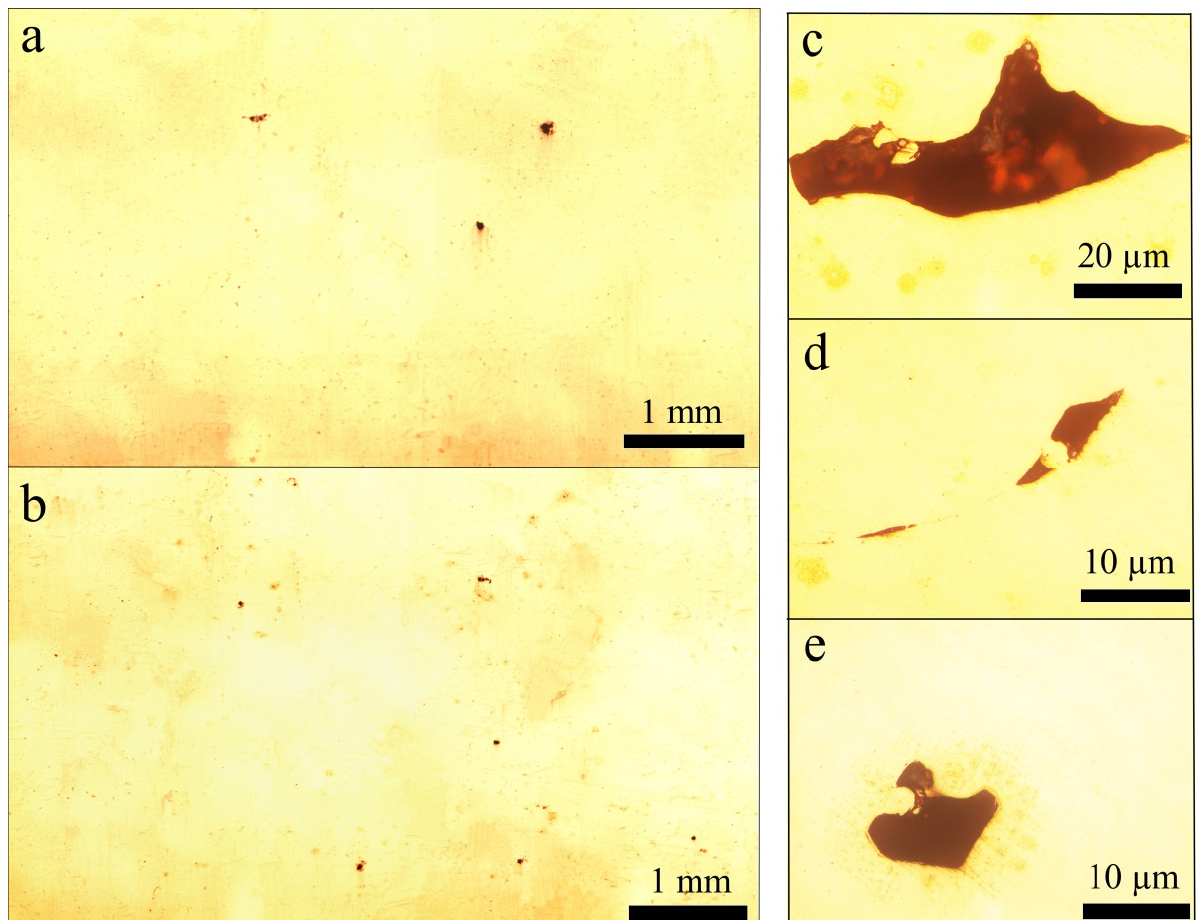
Figure 2. Cross-section of XY ( a ) and XZ ( b ) planes of the most dense sample and typical irregular pores ( c – e ). The regime of LPBF, i.e., energy density (ED), was varied by changing the laser scanning speed to find regularities between density, mechanical properties, and ED, thus revealing optimal synthesis conditions providing the highest possible properties. Energy density is a convenient parameter for evaluation and comparison of the LPBF regimes, which represents energy supply to a unit of volume of the material and is expressed as: